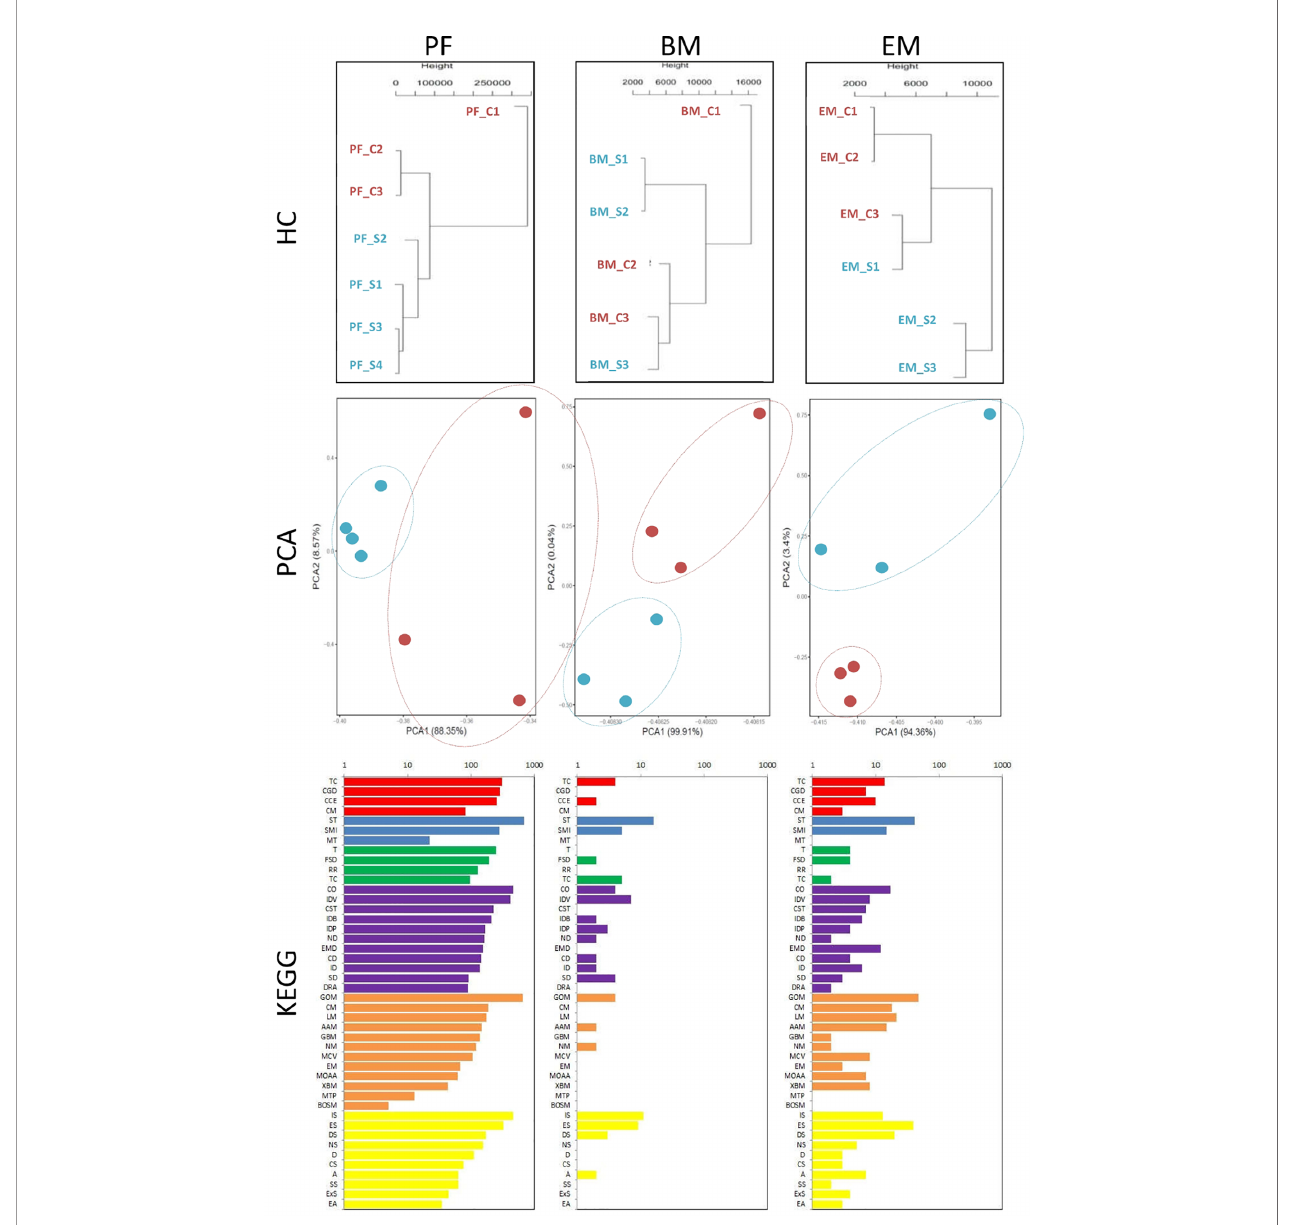
FIGURE 4 | Transcriptomic characteristics of G-MDSC cells and endometriotic lesions. (Upper and middle panels) Hierarchical clustering (HC) and principal component analysis (PCA) of peritoneal (PF) and bone marrow (BM) CD11b+ Ly6G+ G-MDSCs and endometriosis lesions (EM) from 3-4 animals in each group after 7 days of Sunitinib treatment (S in blue labels and dots) versus control (C in red labels and dots). For HC, the closer the samples were to each other, the more similar the expression level was. For PCA, the fi rst and second most coordinated components are shown, similar transcriptomic pro fi les were grouped by circles. (Lower panels) KEGG Pathway functional enrichment. X axis represents the number of DEG, Y axis represents the functional classi fi cation of KEGG according to 7 branches for KEGG pathways: Cellular Processes (red), Environmental Information Processing (blue), Genetic Information Processing (green), Human Disease (purple), Metabolism (orange), and Organismal Systems (yellow). TC, Transport and catabolism; CGD, Cell growth and death; CCE, Cellular community — eukaryotes; CM, Cell motility; ST, Signal transduction; SMI, Signaling molecules and interaction; MT, membrane transport; T, translation; TS, transcription; CO, Cancer — overview;